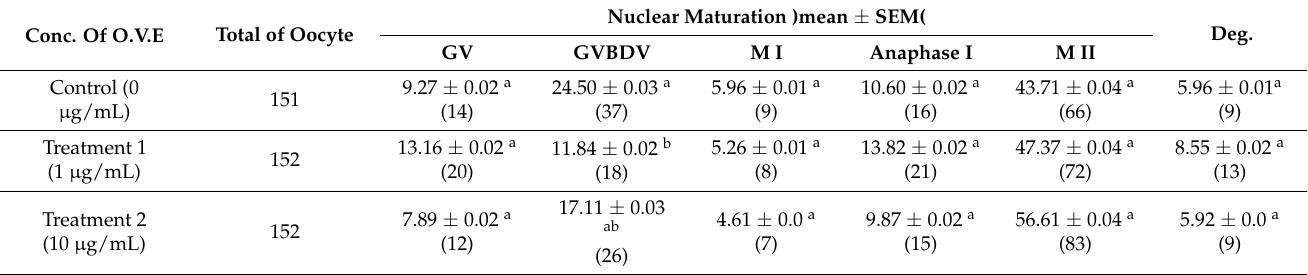
Table 3. The effect of the O. vulgare extract on gene expression of in vitro-matured sheep